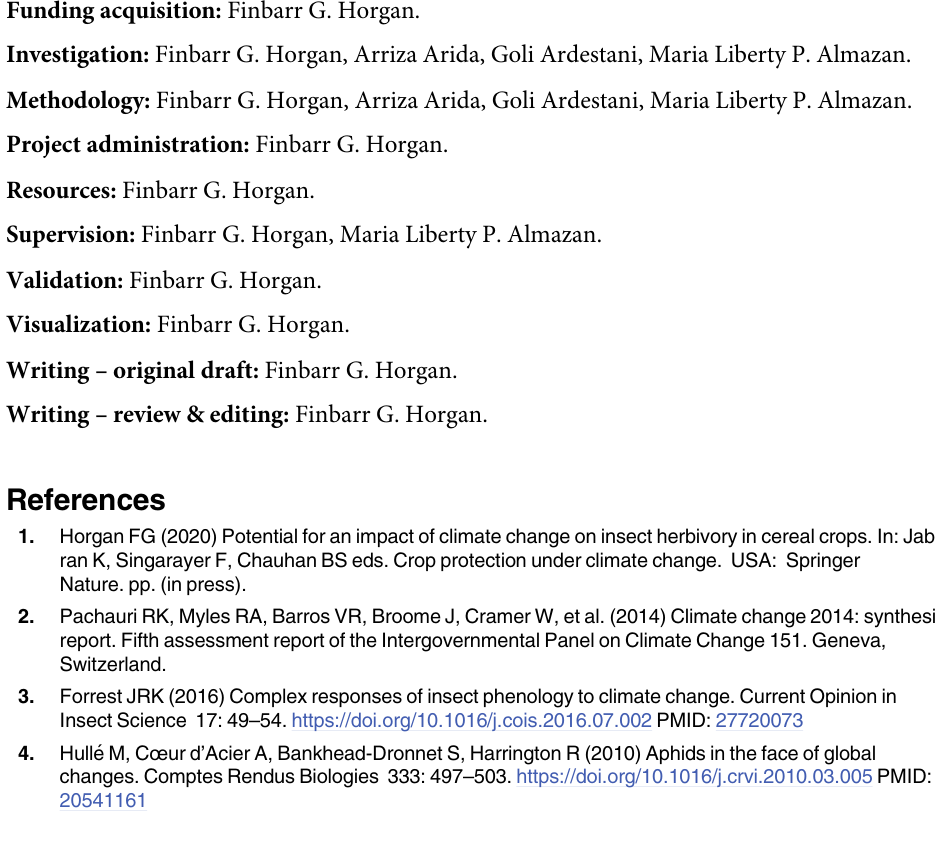
S4 Table. Results of multivariate GLM of nymph development time with species included as an independent factor. S5 Table. Data from environmental chamber studies of responses by ovipositing planthop- pers to temperature. S6 Table. Data from environmental chamber studies of responses by planthopper nymphs to